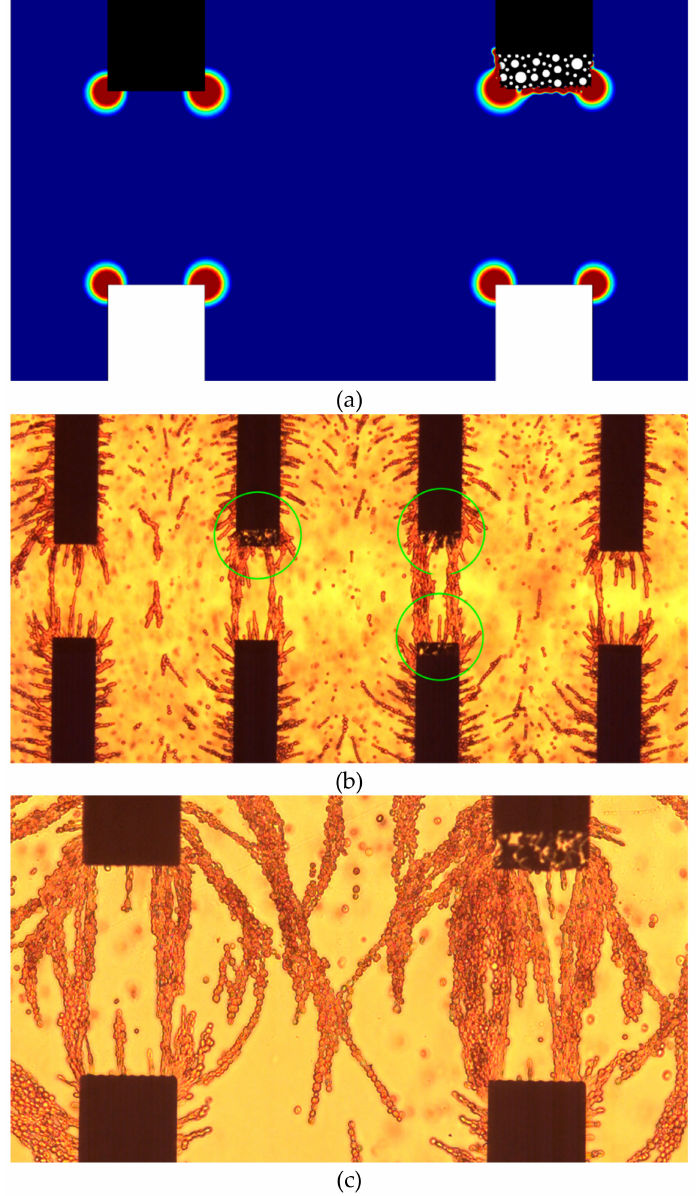
Figure 10. ( a ) The contour plot for the term ∇| E rms | 2 between solid-solid and porous-solid electrodes. The white electrodes are connected to ground. ( b ) The accumulation of red blood cells due to positive dielectrophoresis. Circles are added to indicate the porous electrodes. ( c ) The accumulation of RBCs between the electrodes at higher magnifications. The width of the electrodes is 100 µ m, the applied voltage is 5 volts, and the frequency is 1 MHz for the three